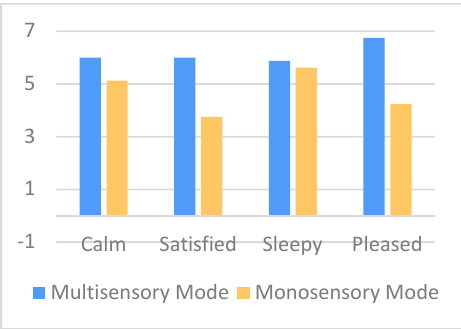
Figure 8. How participants felt after each session ο f the CaLmi evaluation.